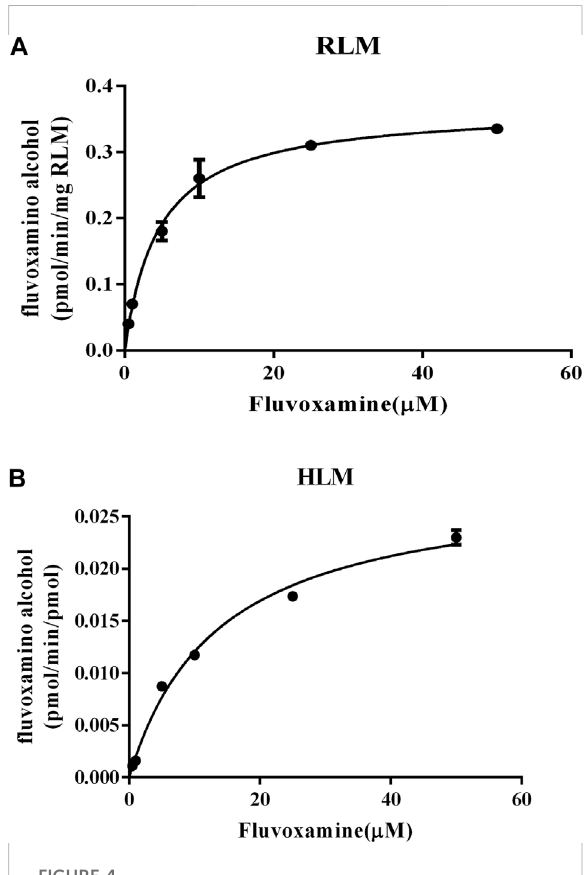
FIGURE 4 Michaelis – Menten curves of fl uvoxamine metabolism in microsomes. (A) RLM. (B) HLM. n =